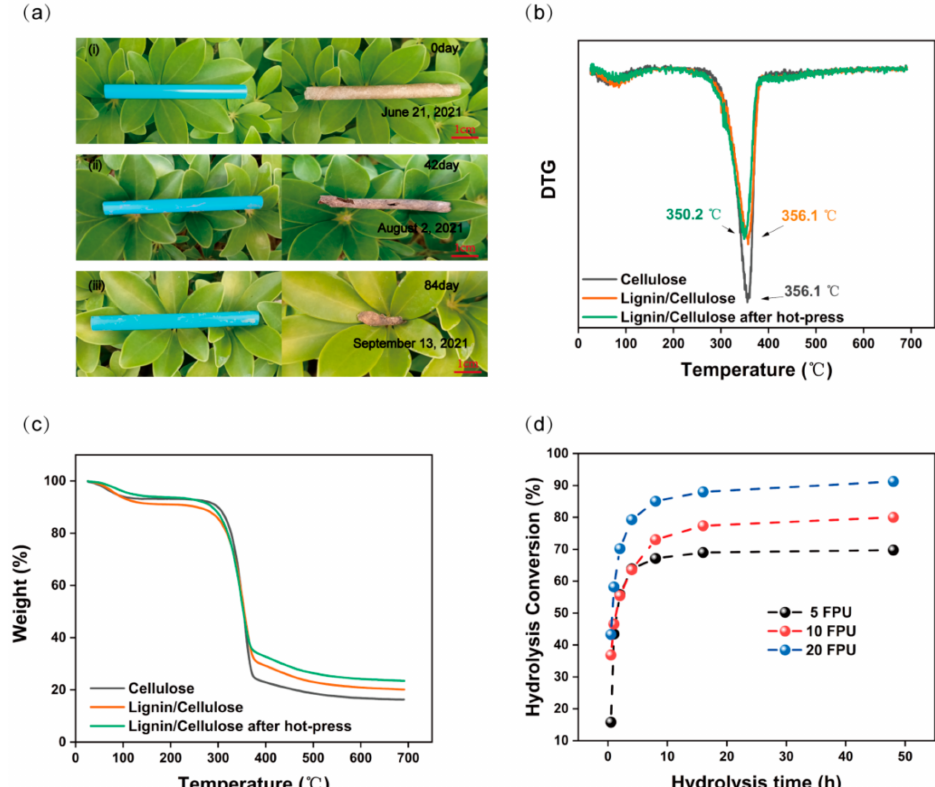
Figure 6. ( a ) (i,ii,iii) The morphology of PP-straw and LCC-straw degraded in nature for 0, 42, and 82 days, respectively; ( b ) thermogravimetric analysis (TGA) and ( c ) differential thermal analysis (DTG) curves of the sheets; ( d ) enzymatic hydrolysis conversion of pretreated bagasse at 5, 10, and 20 FPU/g.